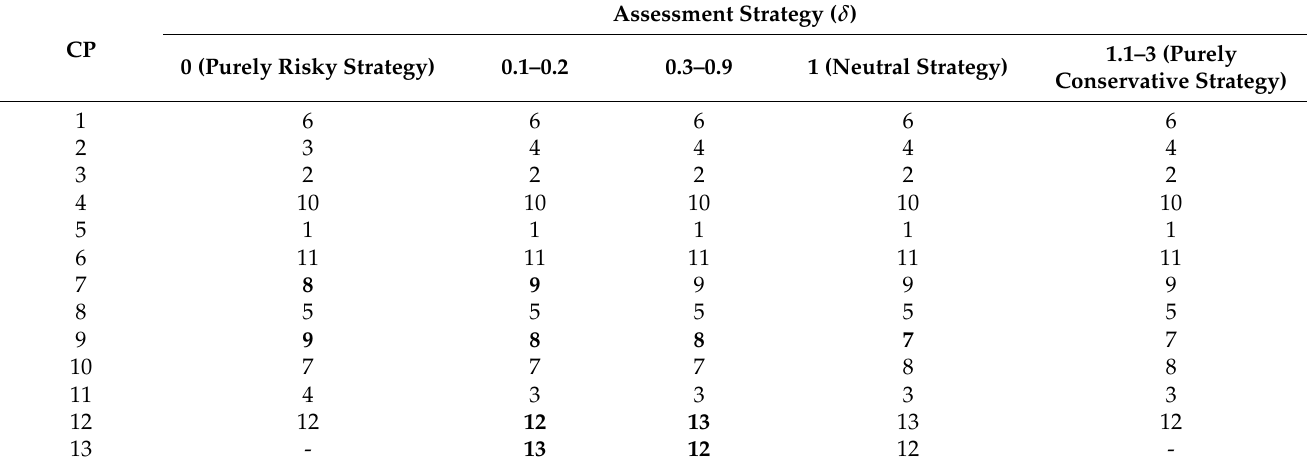
Table 4. CPs ranks in the ordering